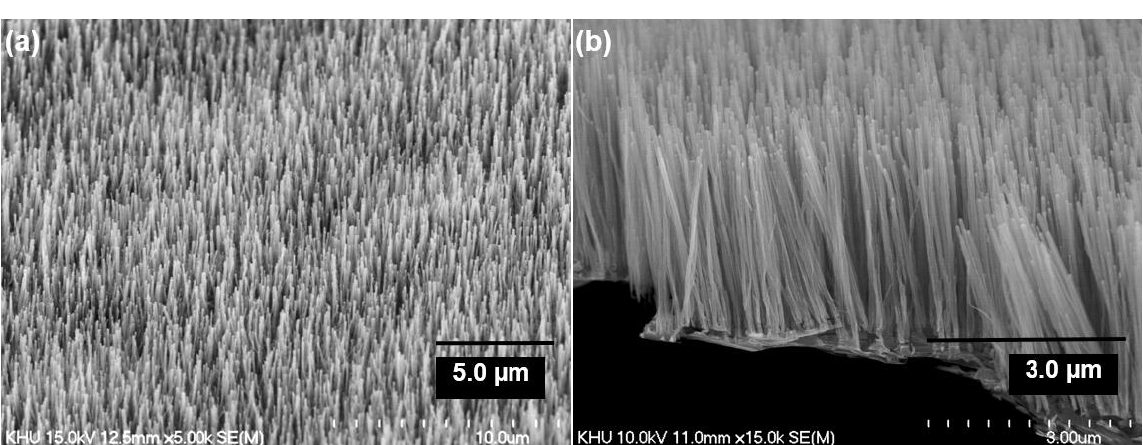
Figure 3. SEM image of ( a ) the morphology of all-carbon electrode; ( b ) cross-sectional SEM Image of the all-carbon